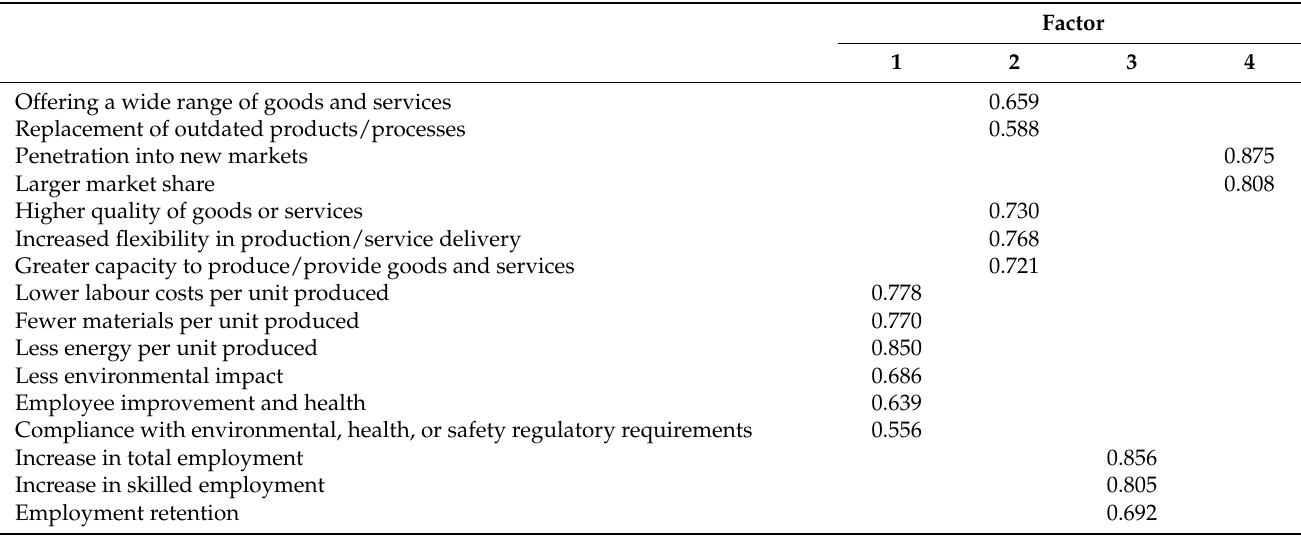
Table 6. Rotated coefficient matrix: innovation